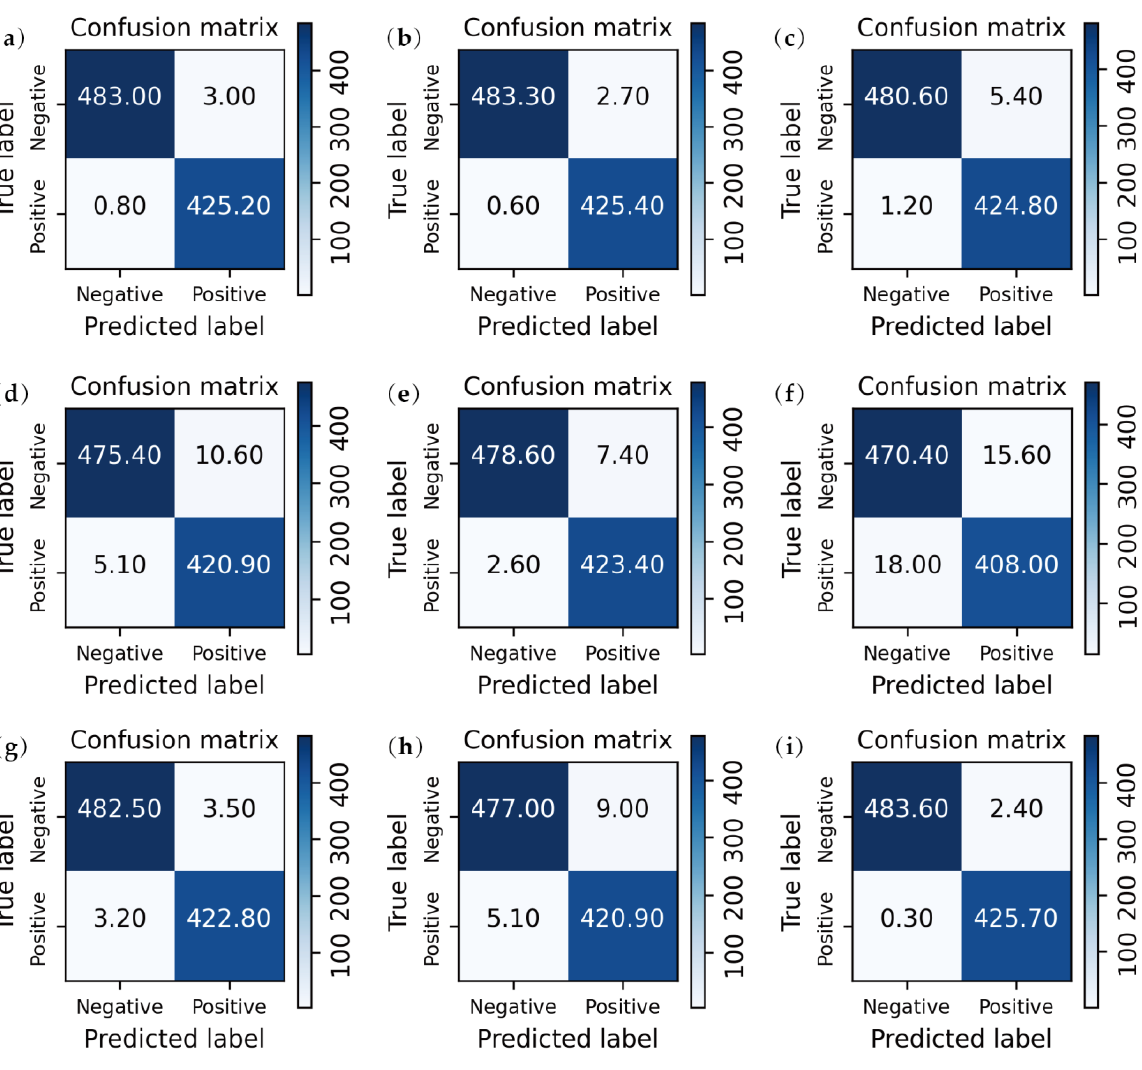
Figure 14. Average confusion matrices for models 1-8 in Table 8, each represented by its corresponding sub-figure ( a – i ).